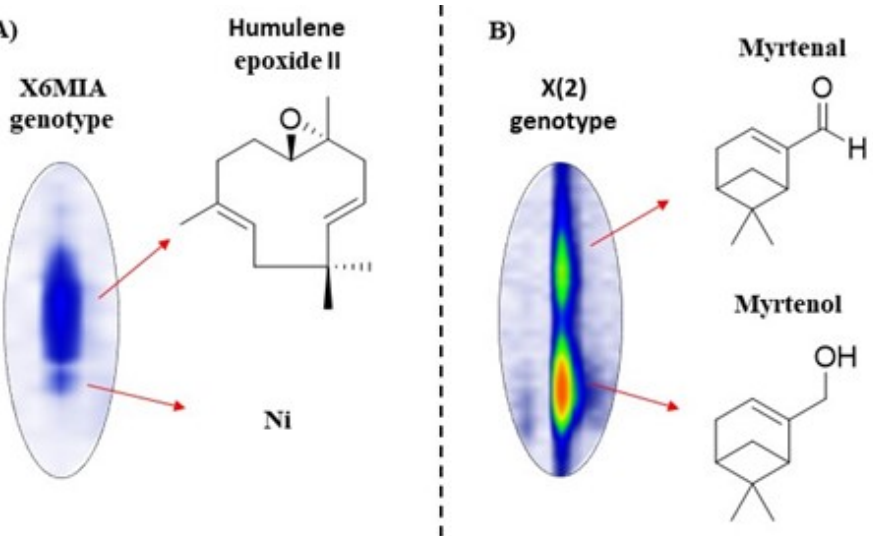
Figure 4. GC×GC-MS contour plots showing examples of improved peak resolution of two over- lapping clusters. ( A ) Coelution between humulene epoxide II (RT1D = 42.33; RT2D = 2.63 s) and an unknown compound (Ni = not identified compound; RT1D = 42.33; RT2D = 2.44 s), ( B )